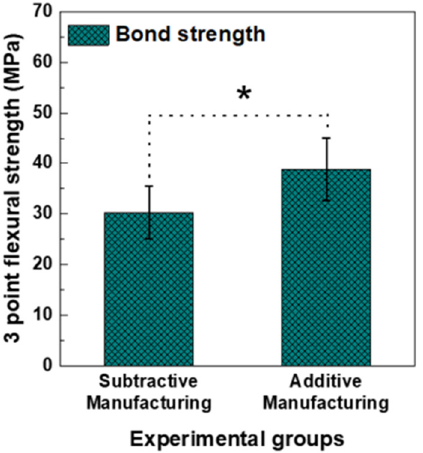
Figure 5. Results of the debonding/crack initiation test between porcelain and zirconia that was block fabricated by subtractive manufacturing and additive manufacturing. The asterisk indicates that there was a significant difference between experimental groups as determined by a t -test at α = 0.05.